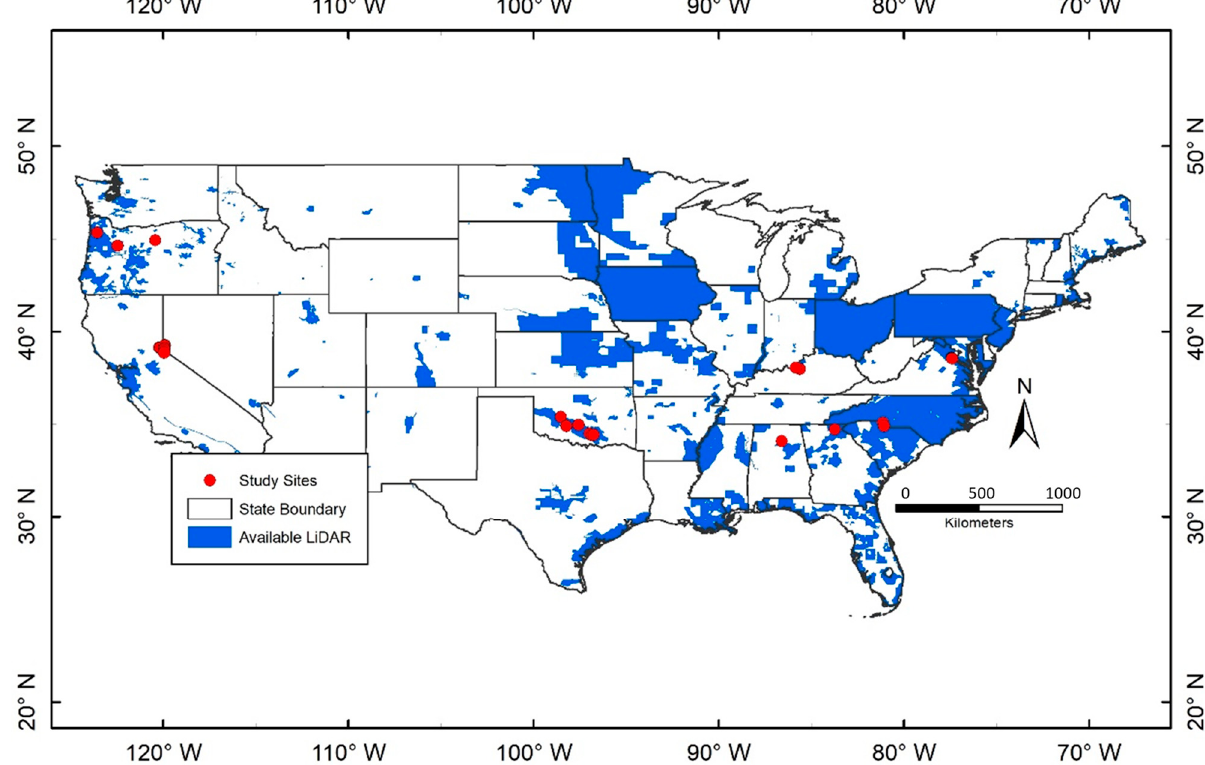
Figure 1. Location of study sites and available LiDAR data. The red dots indicate a total of 30 study watersheds across the ten states and the blue dots means the availability of LiDAR raw point data in the United States as of 2015.